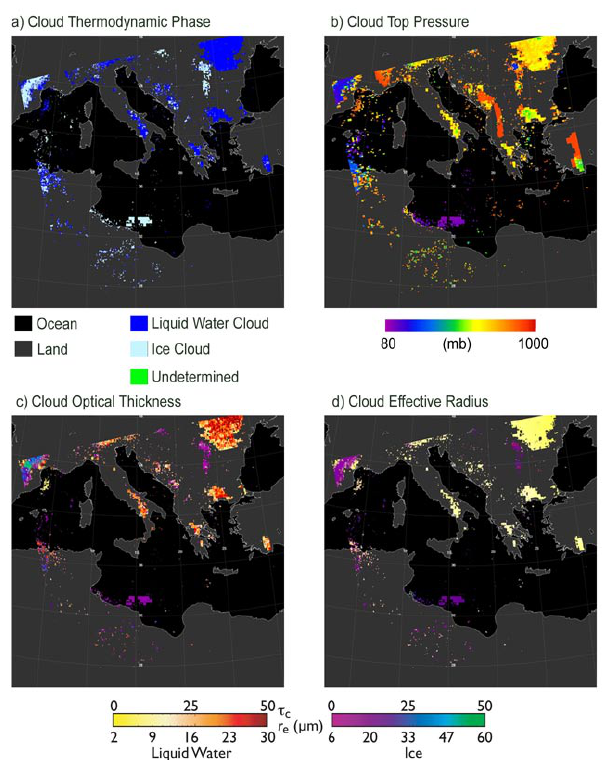
Fig. 2. Example cloud retrieval for simulated granule covered by Aqua MODIS 2012 day 288 12:00UTC. (a) is cloud thermody- namic phase, (b) cloud top pressure, (c) cloud optical thickness and (d) cloud effective radius from the 0.86–2.1µm band